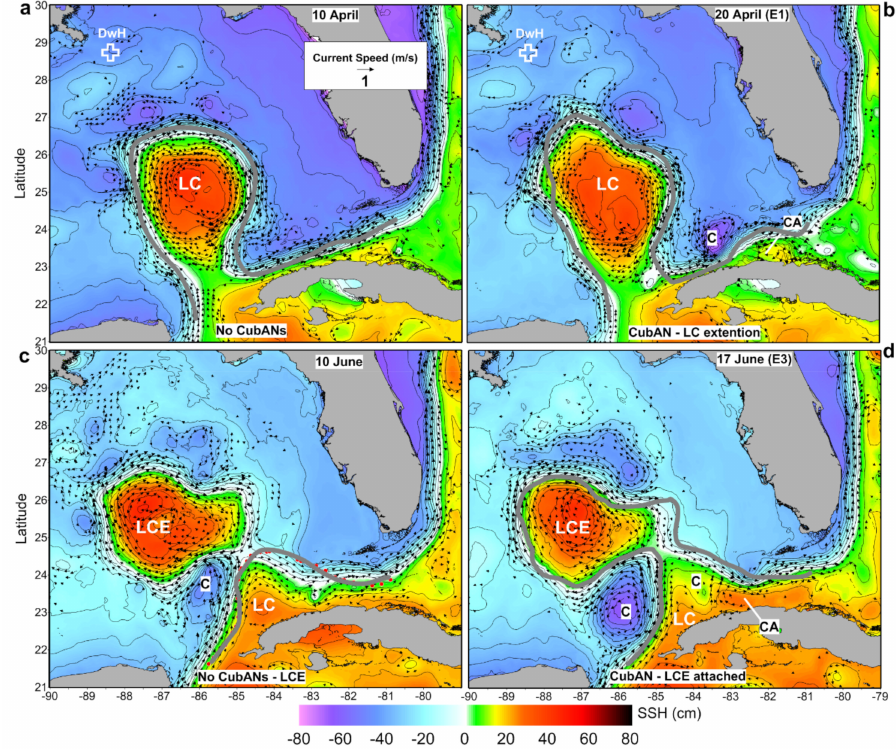
Figure 4. Maps of simulated (GoM-HYCOM 1/50 model) sea surface height (SSH) and surface current vectors (m/s) for characteristic dates before and during two periods of CubAN activity during the oil spill period: ( a ) 10 April, ( b ) 20 April (E1), ( c ) 10 June and ( d ) 17 June (E3). The Loop Current (LC), the LC Eddy (LCE), the major cyclones (C) and the CubAN anticyclones (CA) are indicated. The SSH 17-cm contour, derived from the AVISO fields, is marked with a grey solid line. The location of the DwH platform is marked on ( a , b ) with a